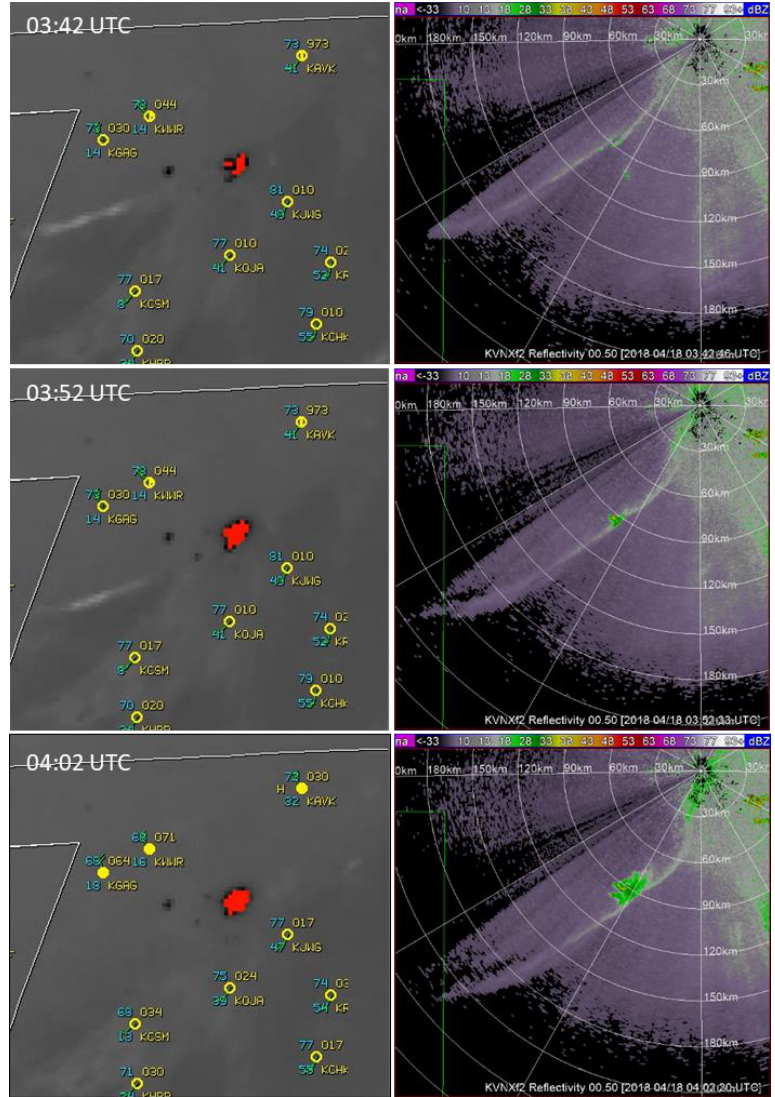
Figure 7. (Left panels) Shortwave infrared images from the GOES-16 satellite of the April 18, 2017 fire in Oklahoma (red patches depict fire locations). (Right panels) Reflectivity fields of the fire taken within 1 min of the satellite images. The color bars indicate Z values in dBZ, and the radar scan is at 0.5 ◦ elevation. Atmosphere 2019 , 10 , x FOR PEER REVIEW